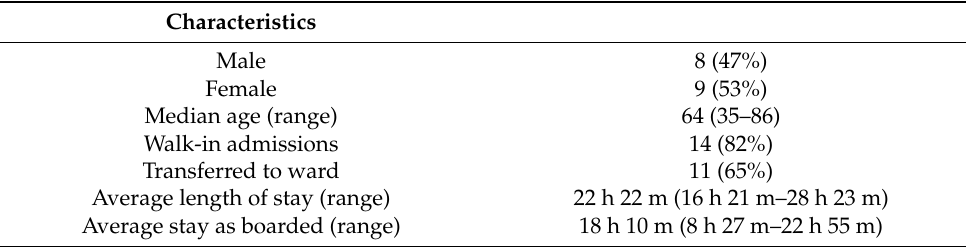
Table 1. Patient characteristics ( n =